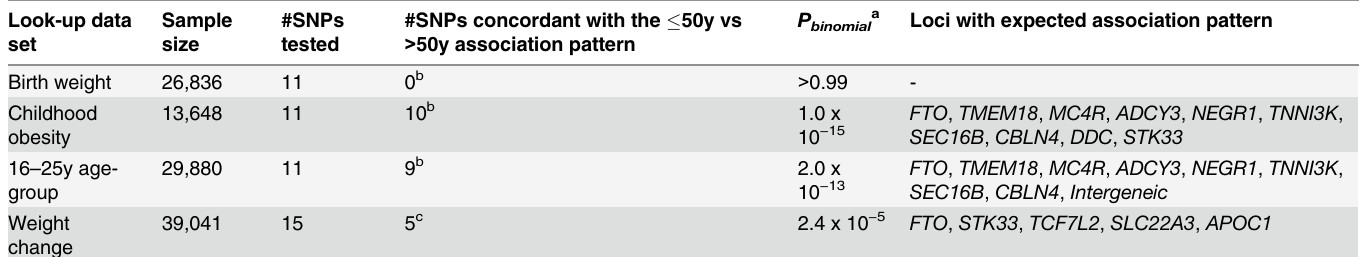
Table 3. Enrichment analyses using look-up data for the 15 age-group specific BMI loci. The look-up data is taken from the EGG consortium for birth weight and for childhood obesity, and from personal communication for weight change trajectories. More details including SNP specific effect sizes or odds ratios and association P-Values on the look-up trait can be found in S15 Table (for birth weight), S16 Table (for childhood obesity) and S18 Table (for weight change). Look-up data